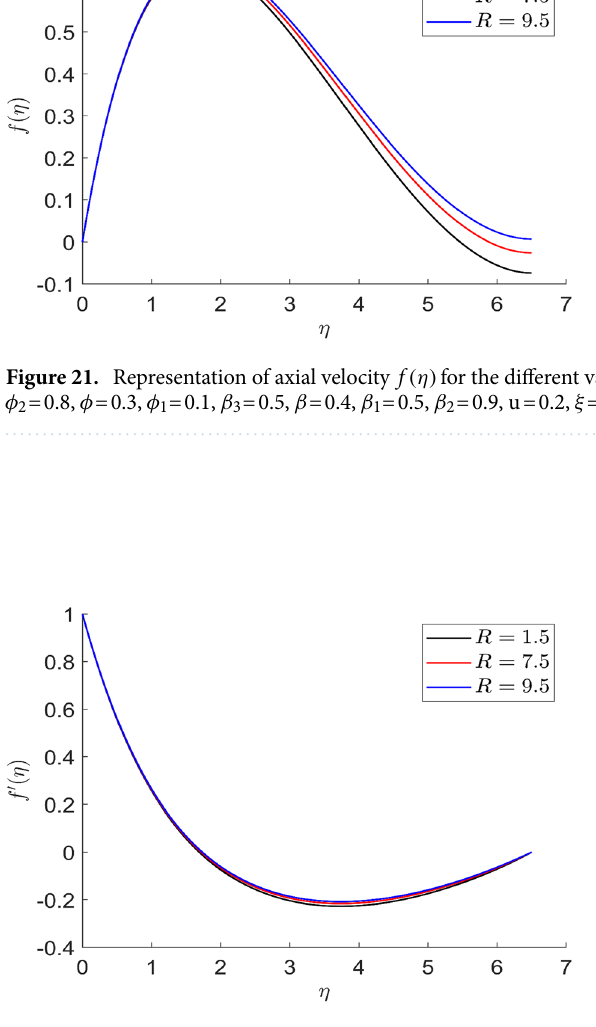
Figure 22. Representation of radial velocity f ′ (η) for the different values of R with R = 3, n = 3, v = 0.7, m = 1.5, φ 2 = 0.8, φ = 0.3, φ 1 = 0.1, β 3 = 0.5, β = 0.4, β 1 = 0.5, β 2 = 0.9, u = 0.2, ξ =